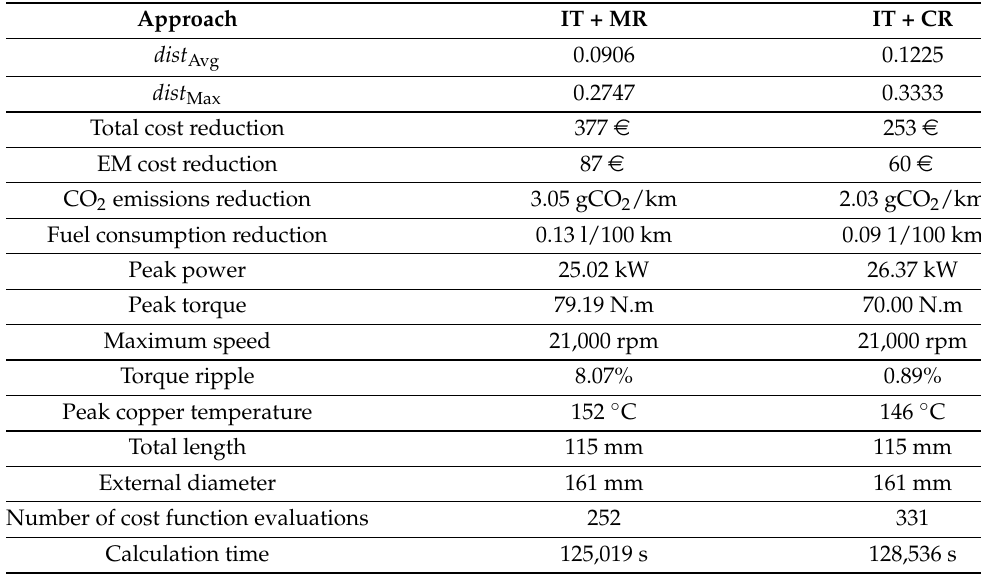
Table 5. Comparison of systemic design approaches based on 4 optimization variables.